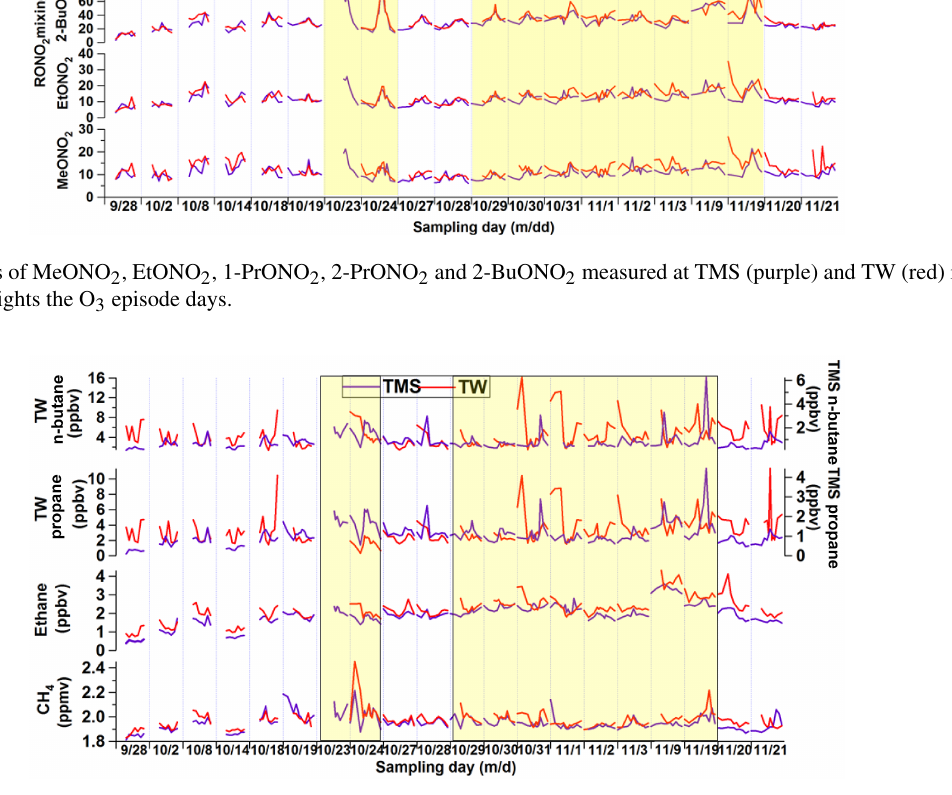
Figure 4. Time series of the parent hydrocarbons of alkyl nitrates at TMS and TW. The yellow shading highlights the O 3 episode